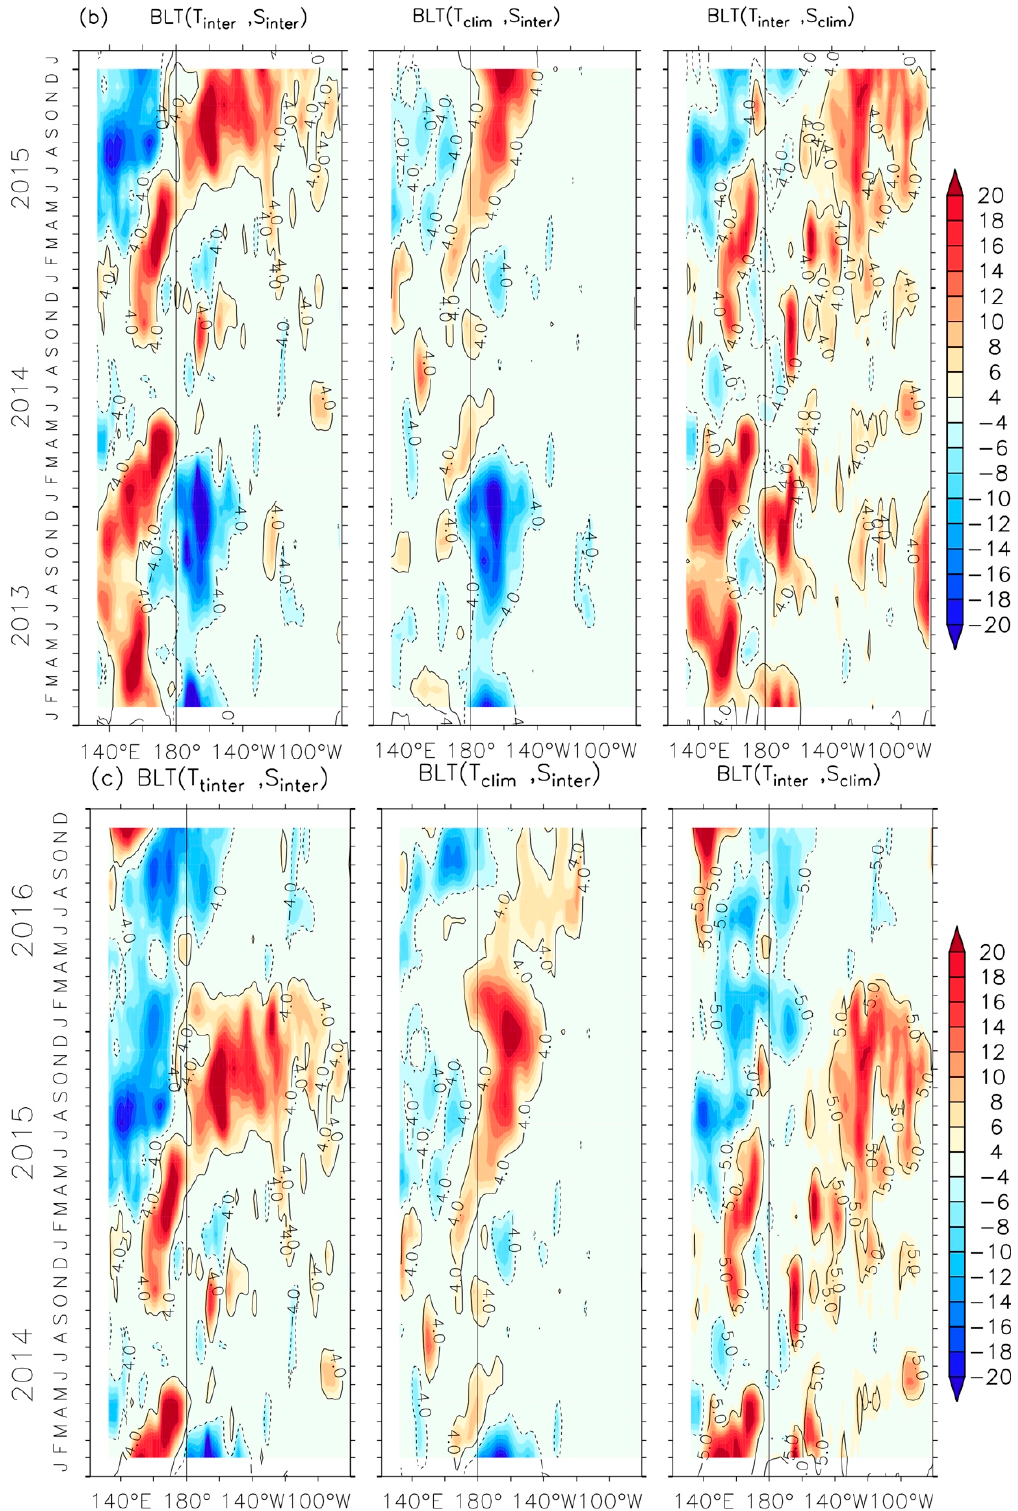
Figure 5. Time evolutions of BLT interannual anomalies along the equator (averaged between 2° S and 2 ° N) for BLT in ( a ) 1997–1998, ( b ) 2014–2015, and ( c ) 2015–2016. These three calculations were made using interannually varying temperature and salinity fields (i.e., BLT (T inter , S inter )–BLT (T clim , S clim )), interannually varying temperature and climatological salinity fields (i.e., BLT (T inter , S clim )–BLT (T clim , S clim )), and interannually varying salinity and climatological temperature fields (i.e., BLT (T clim , S inter )–BLT (T clim , S clim )), respectively.